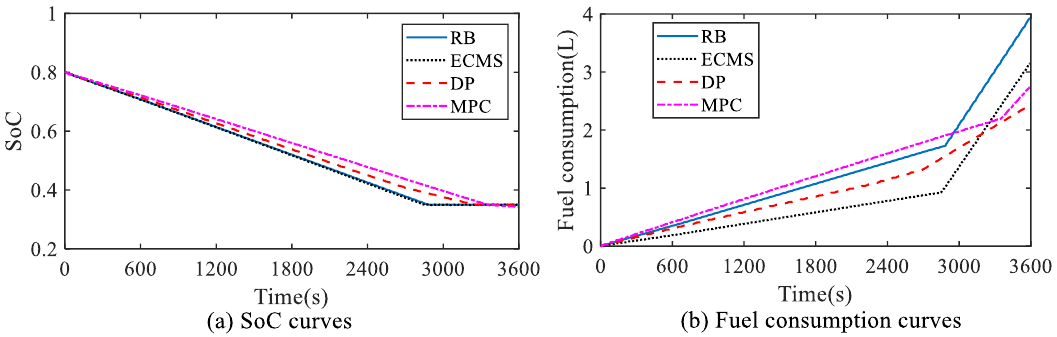
Figure 14. The energy consumption curves of four EMSs.